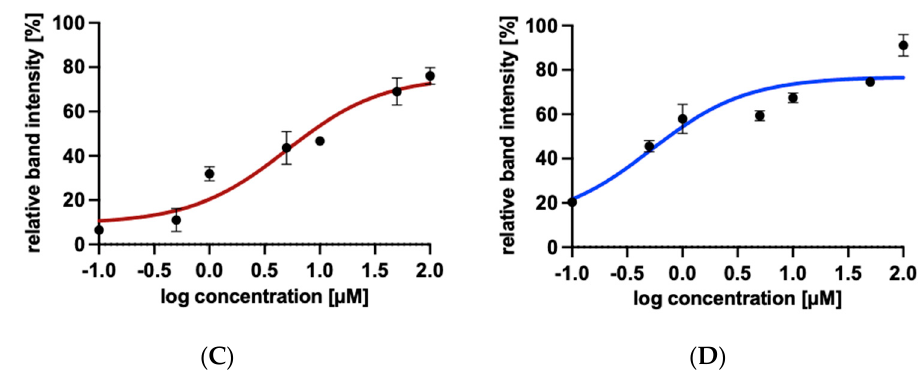
Figure 5. Illustration of the amount of stabilized AAH1 accessible for detection in the presence of increasing concentrations of 4-arylthiosemicarbazide derivatives. ( A ) The stabilization effect of 2a on AAH1 was evaluated by Western blot. ( B ) The stabilization effect of 6a on AAH1 was evaluated by Western blot. ( C ) Dose-dependence curve of 2a on AAH1. ( D ) Dose-dependence curve of 6a on AAH1. The intensities of the AAH1 bands were quantified using ImageJ software. The line was fitted with a three-parameter logistic curve. Data were obtained from three independent experiments and are expressed as the means ± SD.